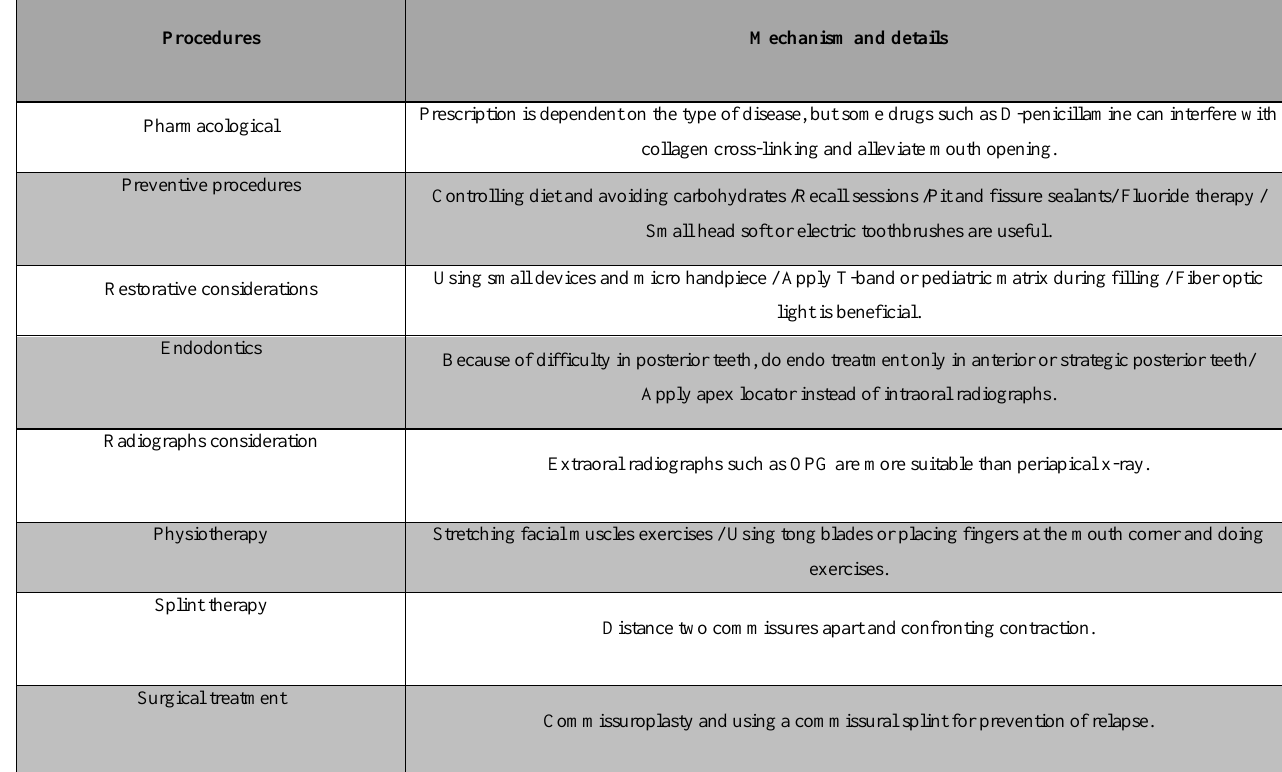
Table 1. Dental consideration of microstomia patients.